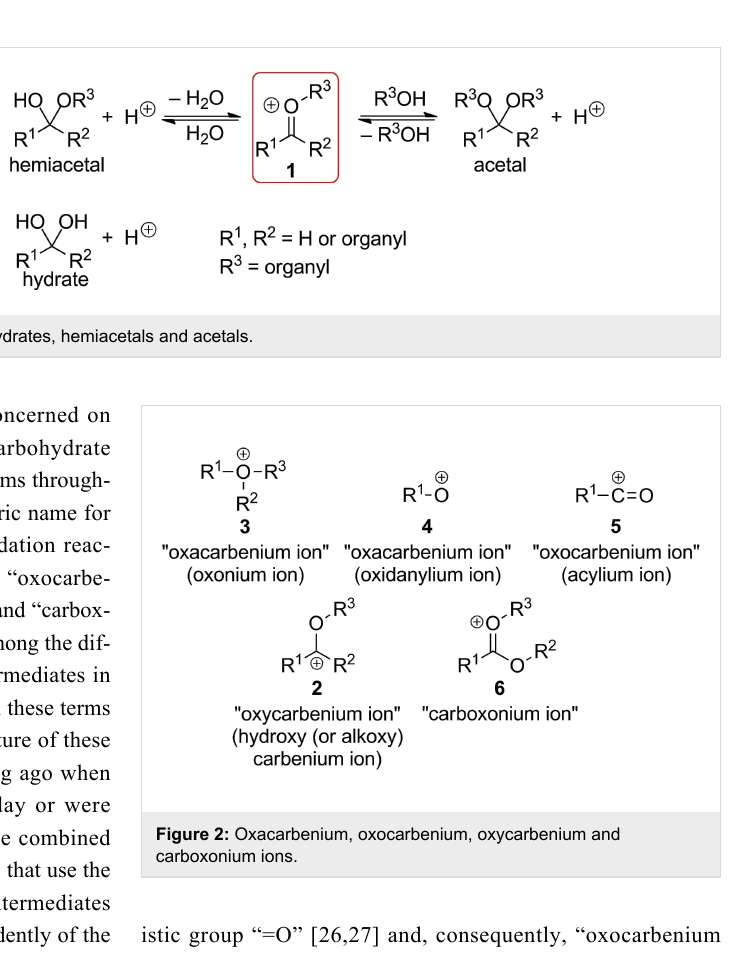
istic group “=O” [26,27] and, consequently, “oxocarbenium ion” is a carbenium ion with the group “=O” (i.e., a synonym of an acylium cation, 5 ; Figure 2), which is the other use found in the literature for this term [23,28]. Not only is the term “oxocar- benium ion” not suitable for describing intermediate 1 , but also it is used to name another intermediate more